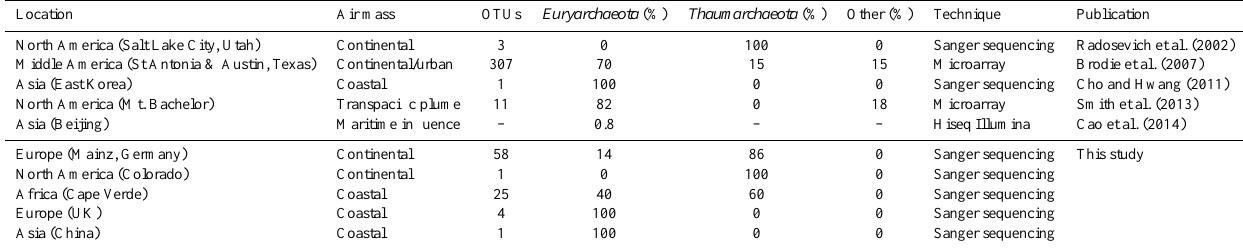
Table 2. Summary of published airborne archaea sequence information. Sampling location, the most likely source of the air masses, the number of reported OTUs, the information as to which archaeal phyla they were attributed to, and the sequencing technique performed. ∗ Another study by Bowers et al. (2013) analyzed bacteria and fungi in air collected at the Colorado Front Range over a 14 month period with the Illumina HiSeq technique. Within this study, archaea were amplified as well; however, no detailed information is provided.